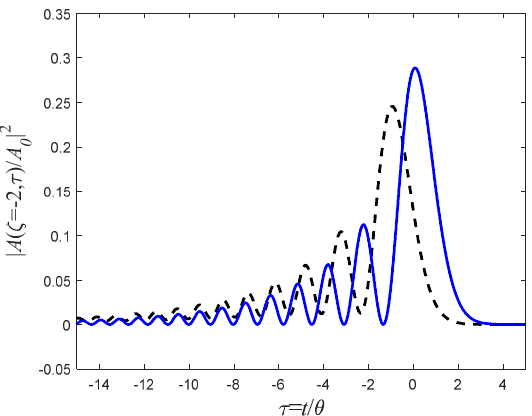
Figure 29. Same as Figure 28, but for the pulse presented by Equation (97), with η / θ = 0.2 and a = 0.1/ θ .